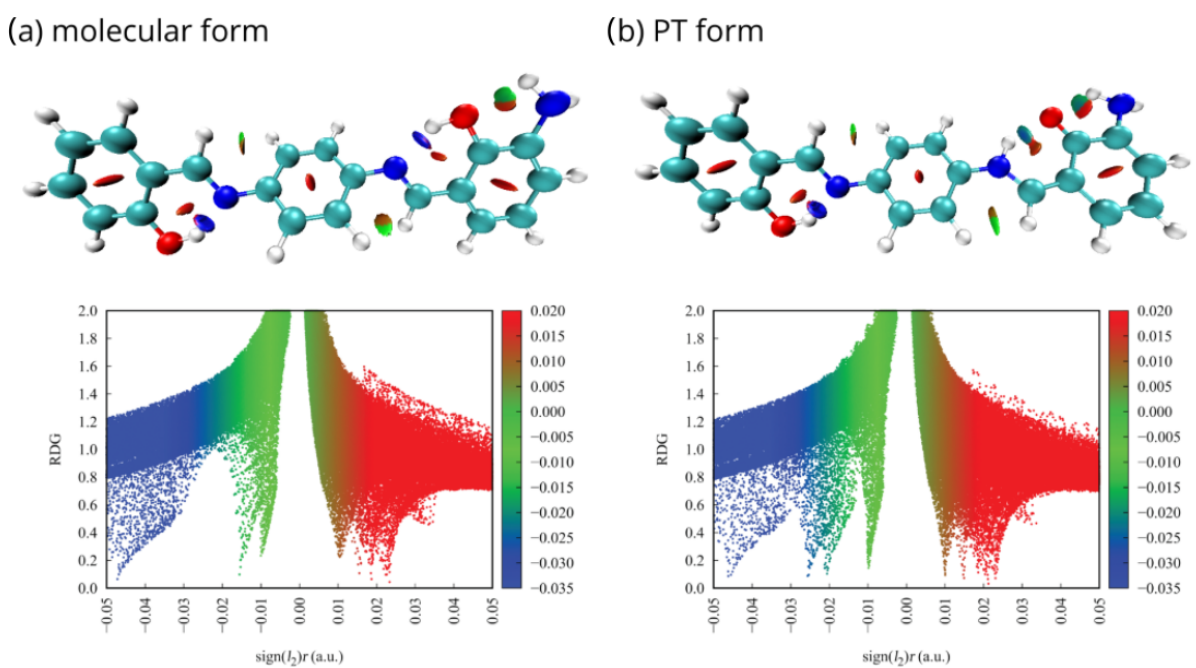
Figure 8. NCI gradient isosurfaces and scatter graphs for the para isomer monosubstituted with the –NH 2 group in the proximal position 4 in the gas phase: ( a ) molecular form, ( b ) proton- transferred